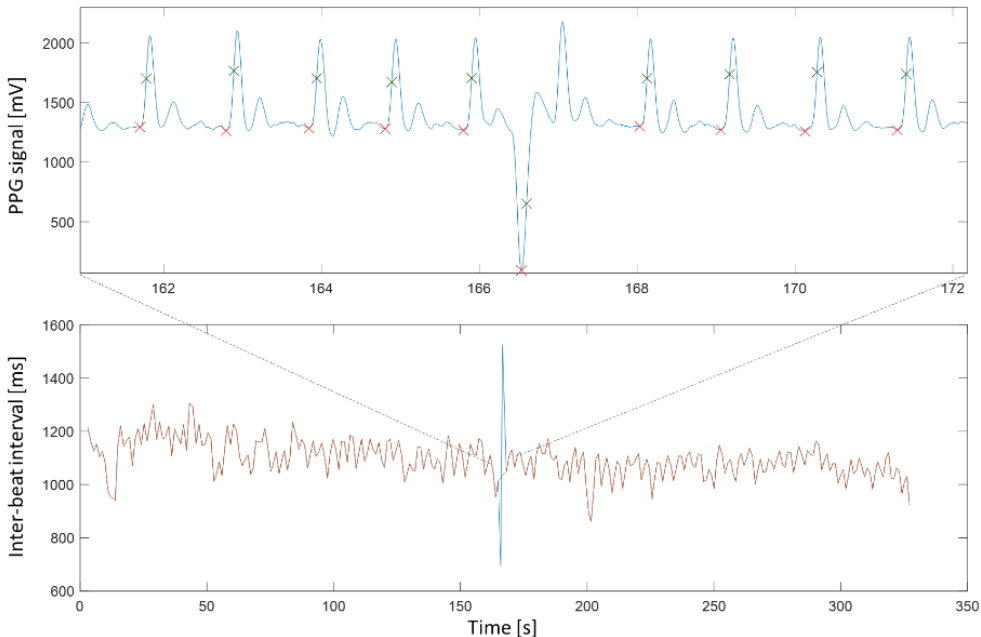
Figure 6. A transient disturbance in the PPG signal (upper plot) causing a large deviation in the estimated inter-beat interval over two points (blue line in lower plot). The red line shows the IBI time-series after outlier correction. The red and green crosses in the upper plot mark the foot and maximum slope fiducial points,